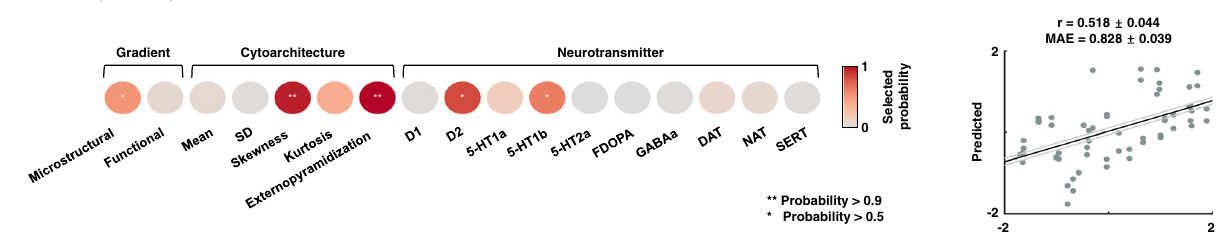
Fig. 4 Association between the shared disease effect and multiscale features using machine learning. a Probability of the selected features across fi ve- fold nested cross-validations and 100 repetitions for predicting the shared disease effect. The frequently selected features are reported with asterisks. b Linear correlation between actual and predicted values of the effects is shown on a scatter plot. The black line indicates mean correlation and the gray lines represent the 95% con fi dence interval for 100 iterations with different training/test datasets. SD standard deviation, FDOPA 18 F fl uorodopa, DAT dopamine transporter, NAT noradrenaline transporter, SERT serotonin transporter, MAE mean